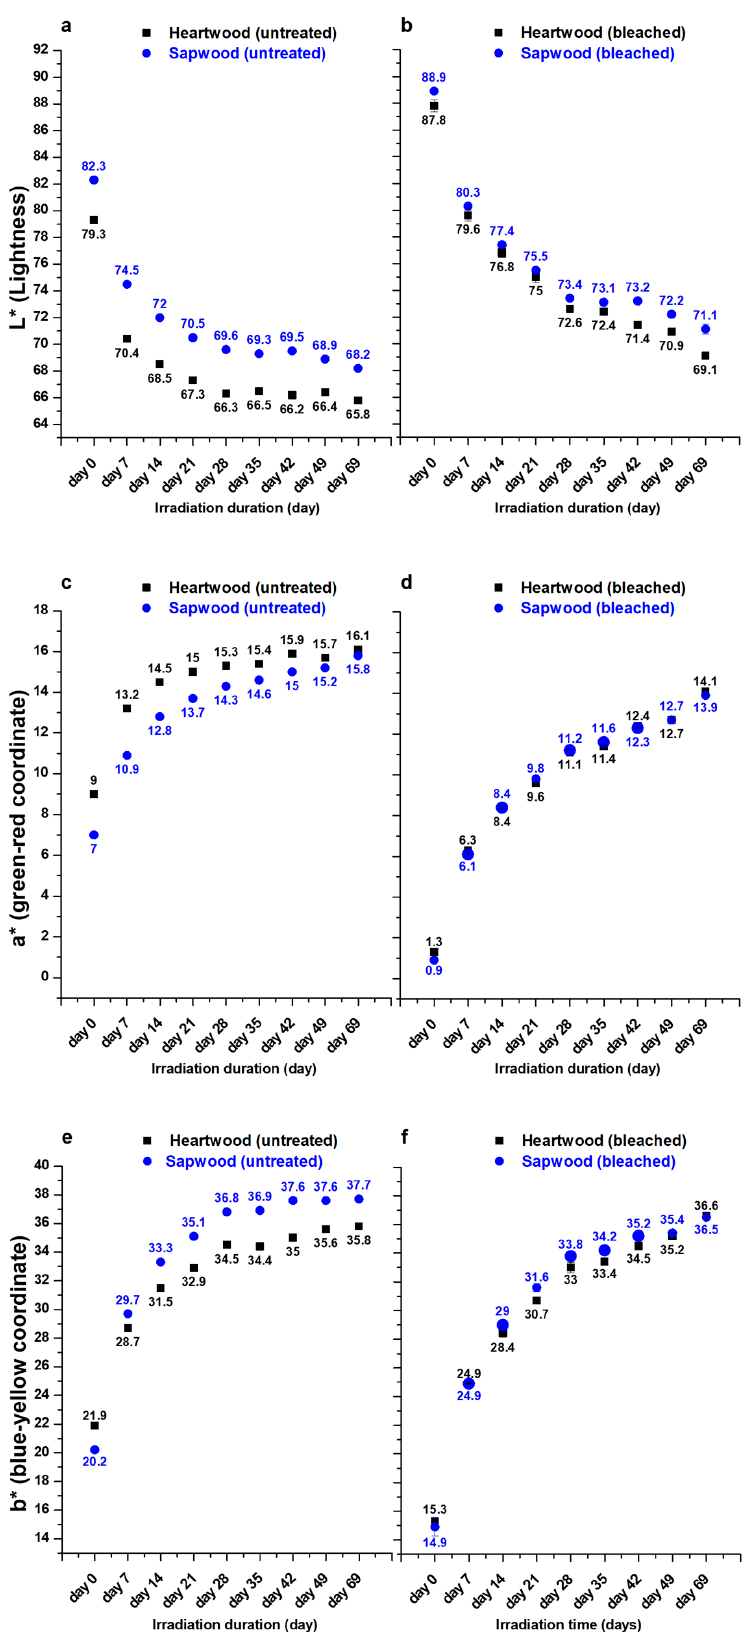
Figure 9. L* ( a , b ), a* ( c , d ) and b* ( e , f ) values evolution during UV irradiation treatment (untreated samples: a , c , e ; H 2 O 2 treated samples: b , d , f ). Chemical changes caused by UV irradiation ageing were observed by ATR analyses (Figure 10). The appearance of a band at 1710–1730 cm − 1 is observed and attributed to the C=O bond of quinone-type fragments formed as described in the mechanism presented in Figure 11.